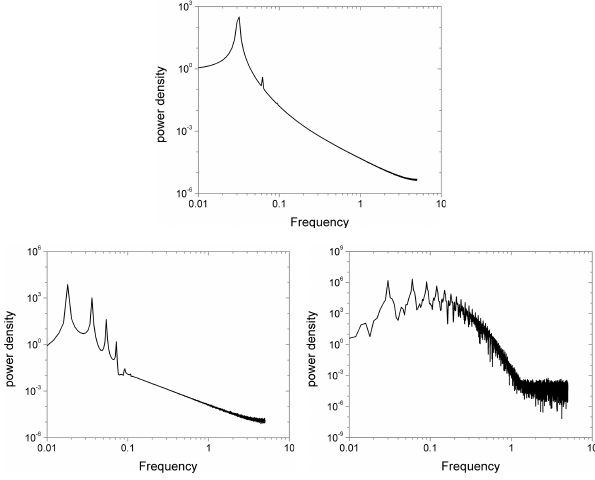
Fig. 2. Parallel-propagating IA soliton space-charge density n sc and the wave-field E x under ξ T =10, and M =1.14 (top panel), 1.16 (bot- tom left), 1.28 (bottom right), showing three types of shapes (sinu- soidal, sawtooth, and spiky/bipolar), respectively.